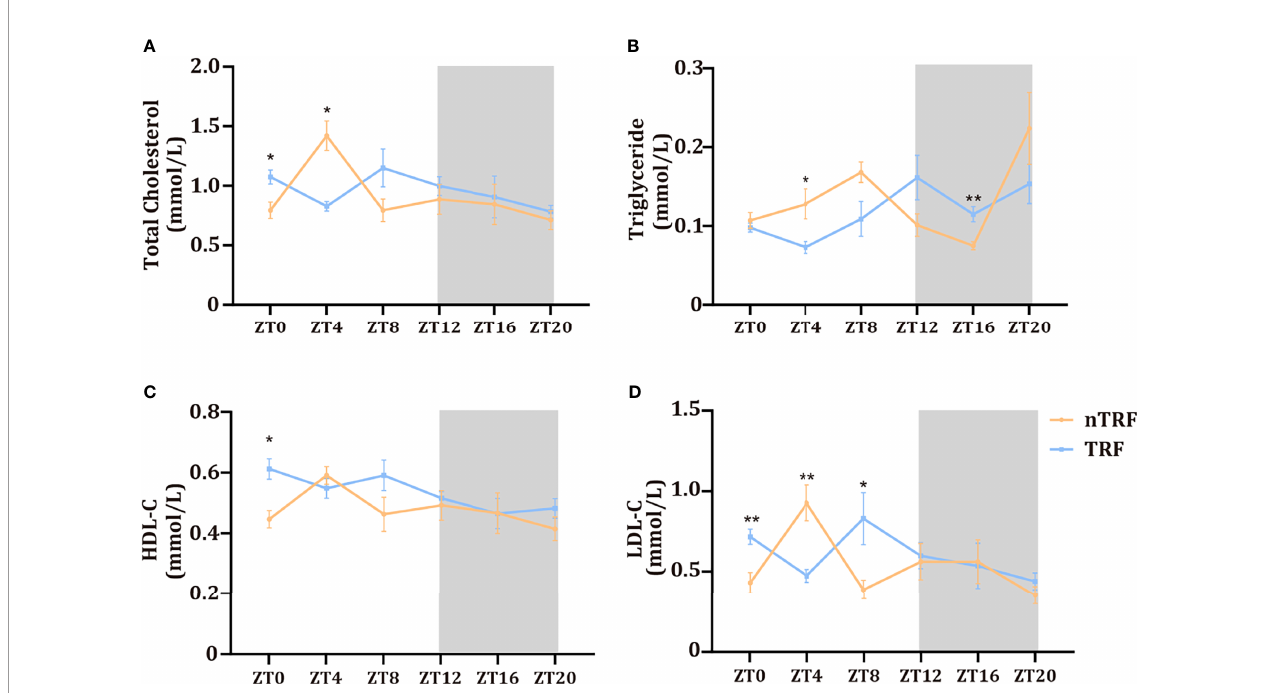
FIGURE 2 | Time-restricted lithogenic diet-feeding (TRF) in fl uences serum lipid concentrations. Serum total cholesterol (A) , triglyceride (B) , HDL (C) , and LDL (D) concentrations at various ZT. Data are expressed as mean ± SEM (n = 5 mice/group at each time point). “ * ” means p < 0.05, “ ** ” means p <